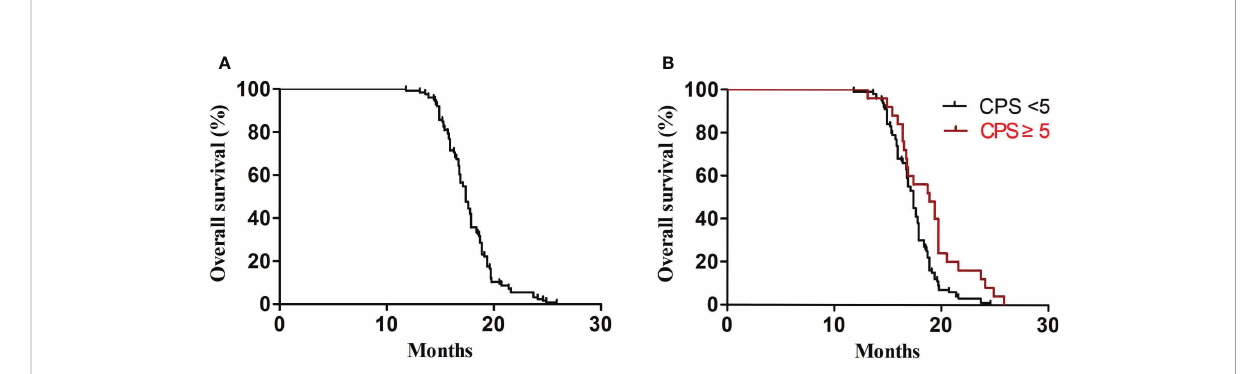
FIGURE 4 OS. (A) Kaplan – Meier analysis of OS in all advanced GC patients. (B) OS according to PD-L1 (P =